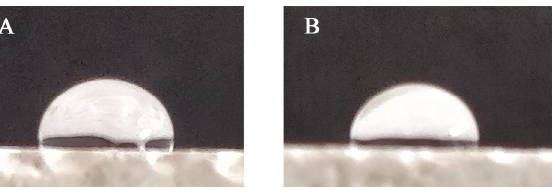
Figure 11. Contact angle measurement on reference mortar ( A ) and on a mortar containing 1.2% ONC ( B ).